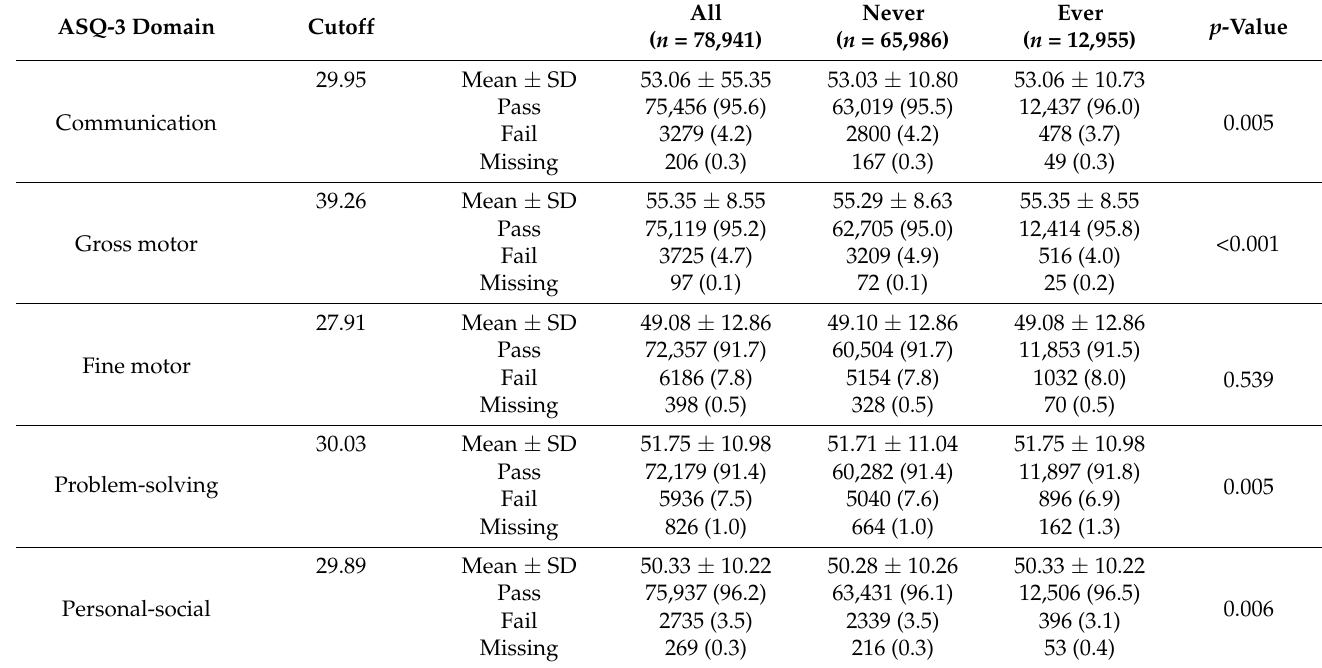
Table 2. Distribution of ASQ-3 scores in association with family dog ownership category. ASQ-3 Domain